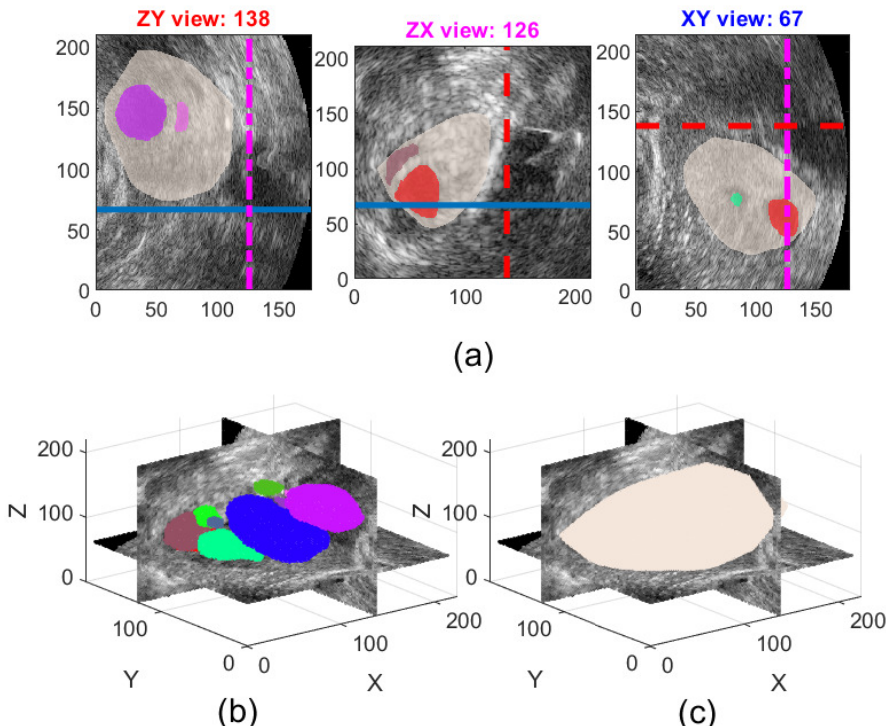
Figure 1. Sample ultrasound volume from the USOVA3D database: ( a ) 2D views of an annotated ovary (ochre) with follicles (coloured) superimposed on the selected cross-sections: ZY plane (left), ZX plane (middle) and XY plane (right); ( b ) A 3D view of the cross-sections, shown in ( a ), through volume with annotated follicles; and ( c ) The 3D view of the corresponding